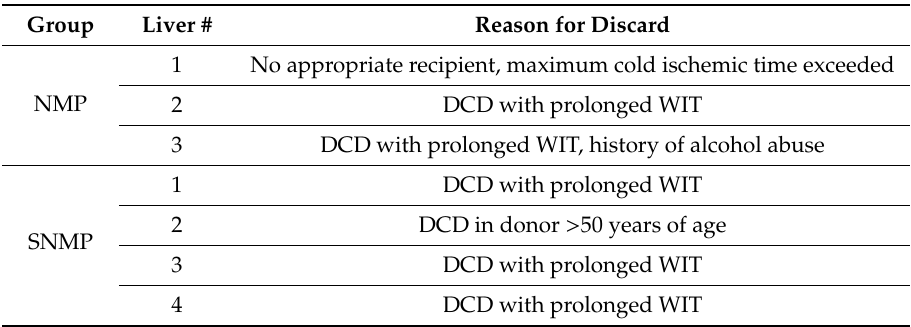
Table 1. Reasons for the discarding of donor